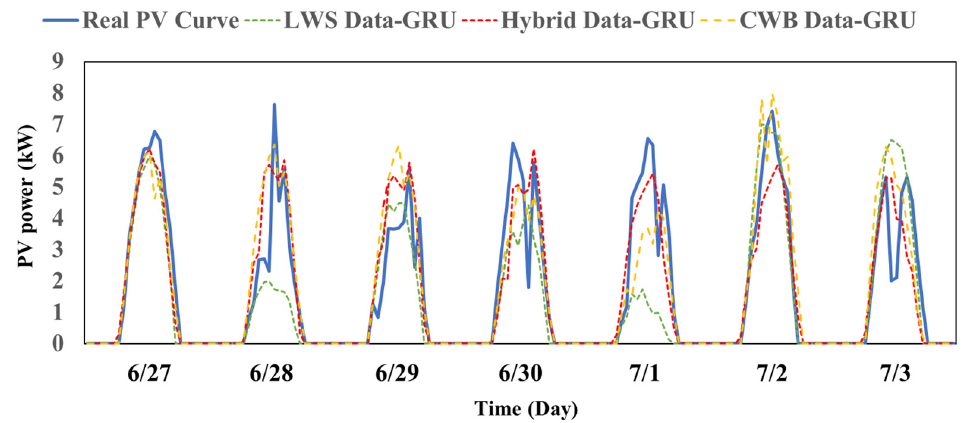
Figure 9. The PV power forecasting results of the GRU model.